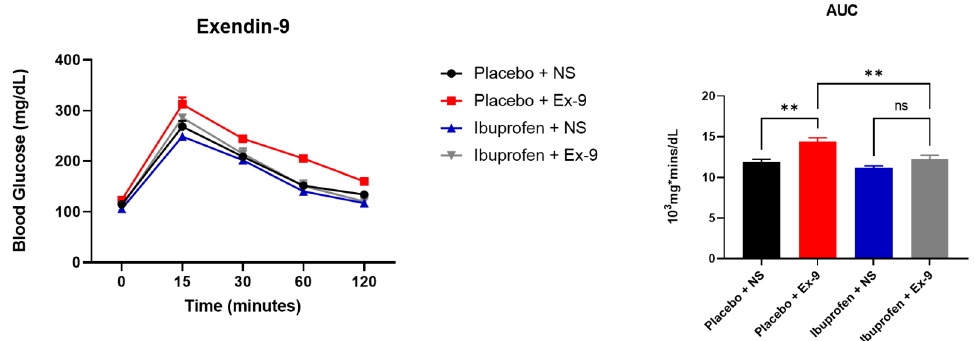
Figure 6. Treatment with GLP-1 receptor antagonist (Exendin-9) worsens glucose tolerance test of placebo but not ibuprofen-treated mice. Glucose tolerance test (GTT) expressed in (mg/dL) in C57Bc/6J mice and treated with placebo vs. ibuprofen for two weeks, followed by the administration of 5 µg of Exendin-9 IP or normal saline 30 min before the experiment: n = 5 (Placebo + NS), 5 (Placebo + Ex-9), 6 (ibuprofen + NS), and 6 (ibuprofen + Ex-9). All results are presented as mean ± SEM (error bars) ( n = 5–6). One-way ANOVA was used to detect differences between control and the three experimental groups. Statistical significances are denoted with asterisks as follows:; **, p ≤ 0.01.